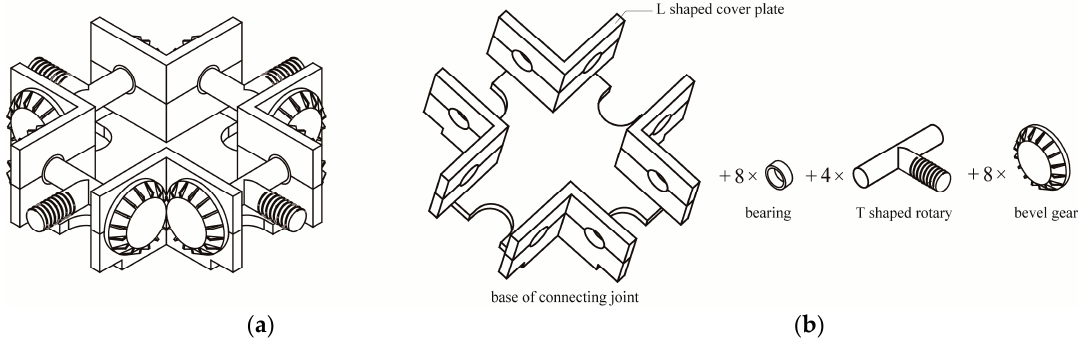
Figure 7. Design of a joint with four pairs of bevel gears and connected to n 1 = 4 link members: ( a ) Sketch of the joint model; ( b ) basic components, including base, cover plate, bearing, rotary, and bevel gears.